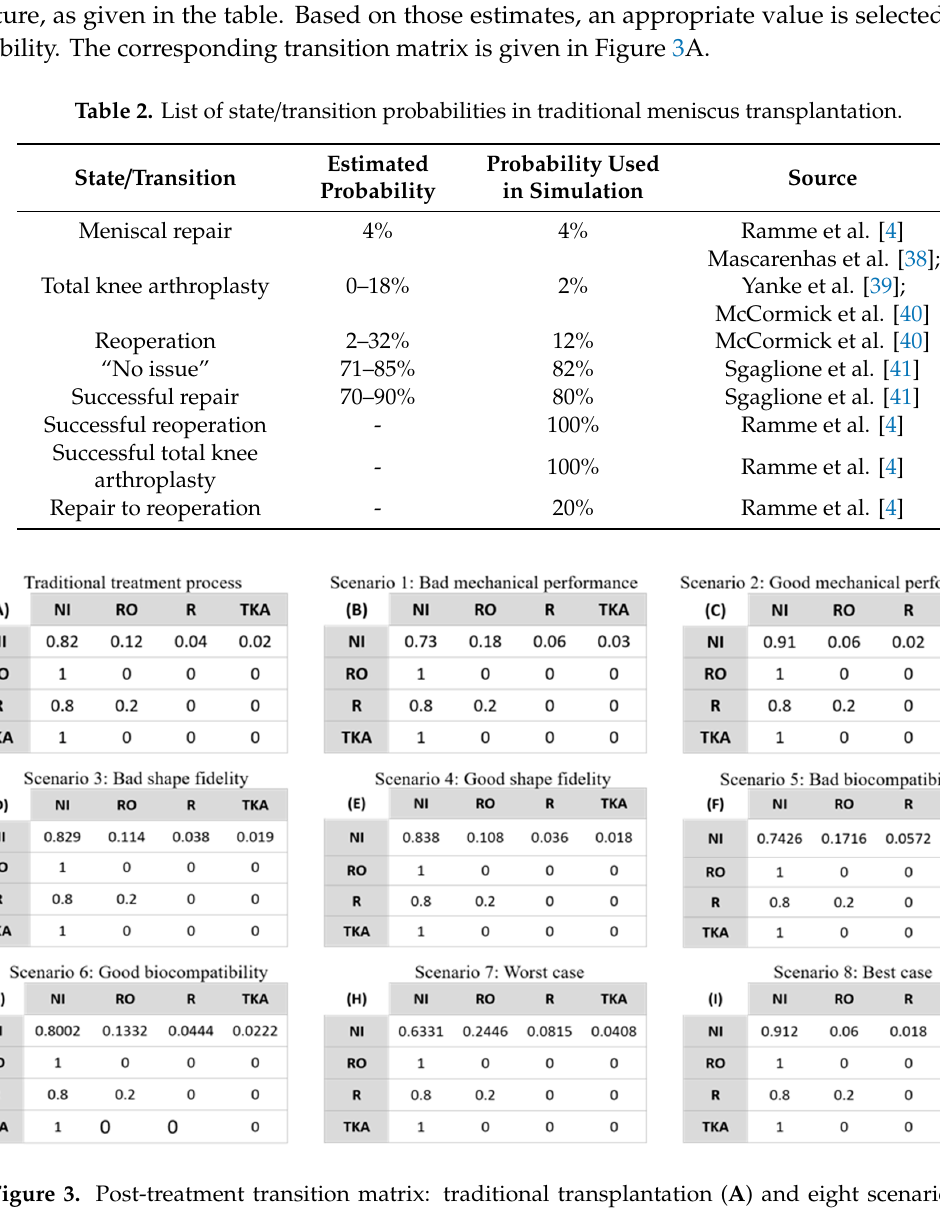
Table 1. List of parameters in the simulation of traditional meniscus transplantation.